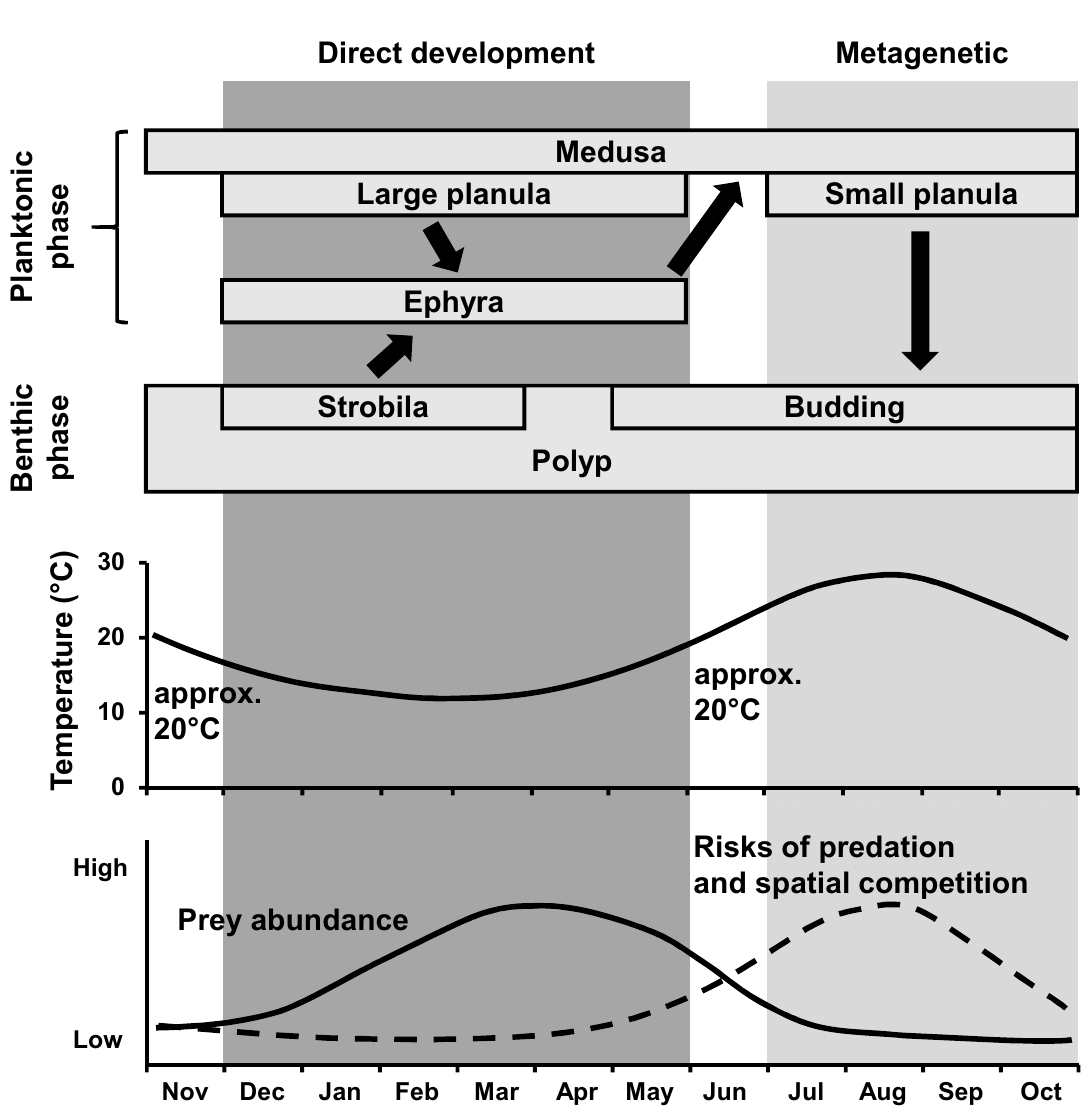
Fig 11. Schematic diagram of the seasonal life cycle of A . coerulea in Maizuru Bay. The timing of strobilation is inferred from Miyake et al., Makabe et al. and Watanabe & Ishii [53–55]. The copepod biomass is treated as prey abundance, with the assumption that it changes linearly from July to October. Risks of predation and spatial competition are inferred from the abundance and filtration rates of filter-feeding sessile organisms, according to Kim & Moon and Ishii & Katsukoshi [56,57].